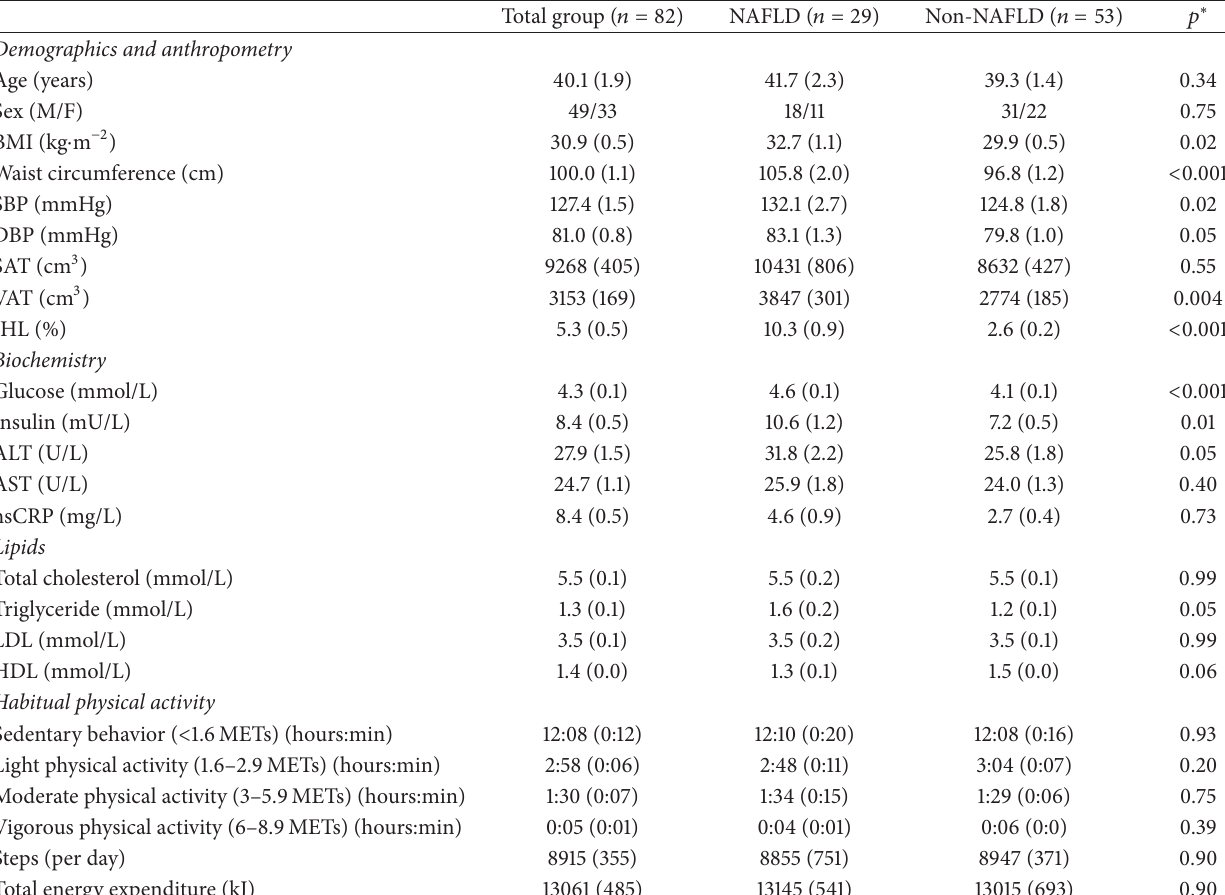
Table 1: Participants’